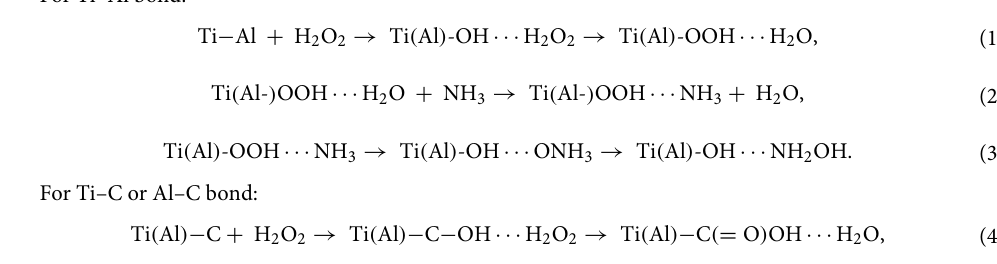
Figure 3a is a cross-sectional SEM images of TiAlC/Si samples before wet etching (35 nm-TiAlC, L0) and after wet etching by chlorine-based solutions and non-chlorine solutions. For chlorine-based solutions, no etching occurred with the mixture of HCl, H 2 O 2 , and H 2 O at a mixture ratio of 1:1:6 (condition L1). A low etch rate of 0.8 nm/min can be obtained with a mixture of HCl and H 2 O 2 (10:1, condition L2). For non-chlorine solutions, no etching occurred with H 2 O 2 solution (condition L3). A high etch rate of 2.3 nm/min can be obtained by using a NH 4 OH/H 2 O 2 /H 2 O mixture (2.2:3:52, condition L4). Wet etching of TiAlC by non-halogen liquid mixtures at different etch time was done by NH 4 OH/H 2 O 2 /H 2 O mixture. The surface modification of TiAlC film after wet chemical etching in NH 4 OH/H 2 O 2 /H 2 O mixture at room temperature is analyzed by XPS spectra, as shown Fig. S2. The intensity of Ti 2p and Al 2p was significantly reduced after 5 min and 10 min etching, whereas C–C bond at 284.8 eV (C 1s) was significantly increased. N–H and C–N peaks (around 400 eV) can be found in N 1s spectra after etching. This indicates that the compounds containing C–C and C–N bonds after wet etching of TiAlC surface are not able to dissolve in NH 4 OH/H 2 O 2 / H 2 O mixture. As a result, Ti and Al could be dissolved in the solution; however, the TiAlC surface was covered with the C-C and C–N bonds. Based on the XPS results and the studies of Kakihana et al. and Sirijaraensre et al. on dissolution of Ti compounds 24,25 , the reaction of NH 4 OH/H 2 O 2 /H 2 O mixture with TiAlC to form hydroxylamine or other com- pounds can be assumed as follows. For Ti–Al bond: